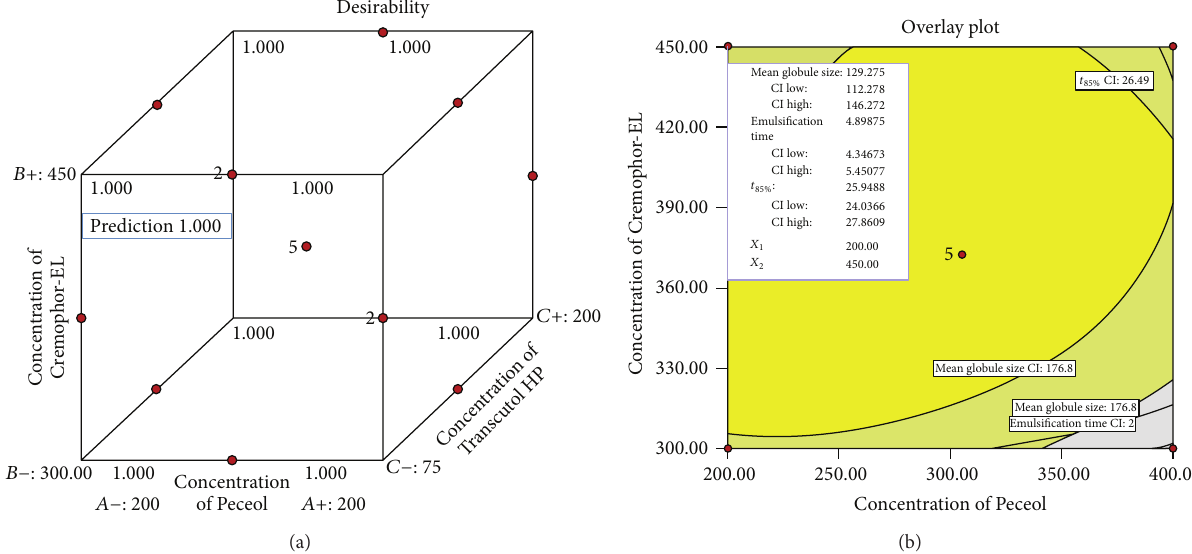
Figure 4: Cube surface and overlay plot for overall desirability [ D ] as a function of Peceol and Cremophor-EL.